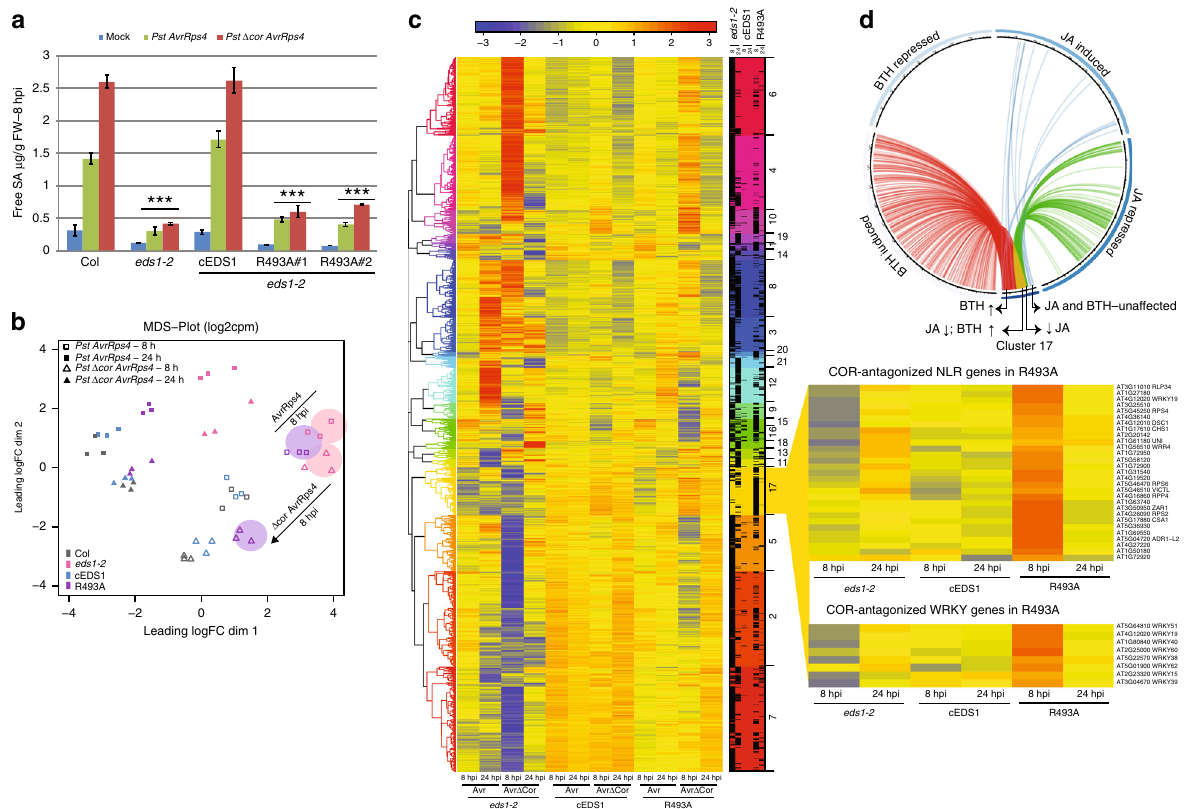
Fig. 4 Delayed immune signalling in R493A mutant plants is independent of COR. a Four-week-old plants were in fi ltrated with 10 mM MgCl2 (mock), Pst AvrRps4 or Pst Δ Cor AvrRps4 and free SA was quanti fi ed at 8 hpi. Bars represent means ± SE of three biological replicates. Difference between genotypes were analysed using t-test (Bonferroni corrected, p < 0.05). Similar results were observed in three independent experiments. b A multi-dimension scaling (MDS) plot of differentially expressed genes showing R493A transcriptional changes at 8 (open symbols) and 24 hpi (closed symbols). Encircled samples of eds1-2 (pink) and R493A (purple) highlight transcriptional trends with and without bacterial COR in Pst AvrRps4 -triggered immunity. c A heatmap depicting DEG at 8 and 24 hpi normalised to Col ( p < 0.05) after hierarchical clustering. Samples were harvested at 8 and 24 hpi with Pst AvrRps4 (Avr) and Pst Δ Cor AvrRps4 ( Δ Cor). Cluster #17 contains genes that are upregulated at 8 hpi with Pst Δ Cor AvrRps4 but not Pst AvrRps4 in R493A only. Expansion (right) highlights a subset of NLR and WRKY genes in cluster #17 involved in immunity whose expression is antagonised by COR in R493A (see Supplementary Table 3). d Circos plot showing overlap of 383 genes in cluster #17 with genes regulated by JA and Benzothiadiazole (BTH, an analogue of SA) from other studies (Hickmann et al.,2017; Yang et al.,2017). Genes differentially expressed in cluster #17 and other datasets are marked by connecting lines. Genes repressed by JA and induced by BTH (red and green lines converging to yellow, 113); genes repressed by JA and not expressed by BTH (green lines, 19); genes induced by BTH and not expressed in JA dataset (red lines,